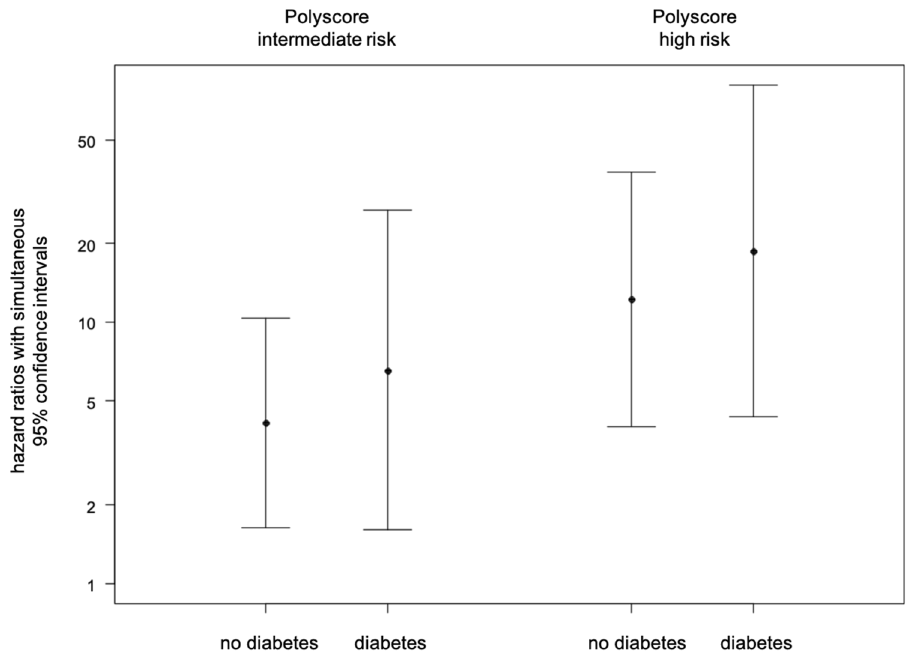
Figure 3. Hazard ratios with simultaneous 95% confidence intervals in patients with and without diabetes mellitus. Reference: Polyscore low